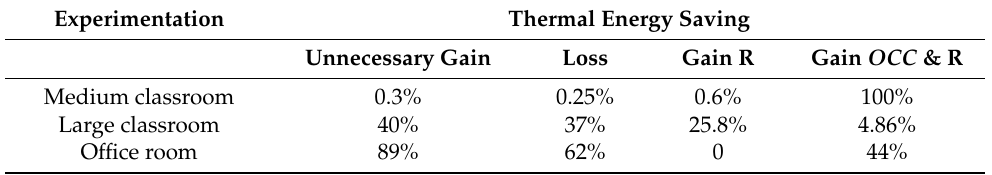
Table 4. The thermal energy savings of the FC vs. On /Off controller in the living spaces. Experimentation Thermal Energy Saving Unnecessary Gain Loss Gain R Gain OCC & R Medium classroom 0.3% 0.25%